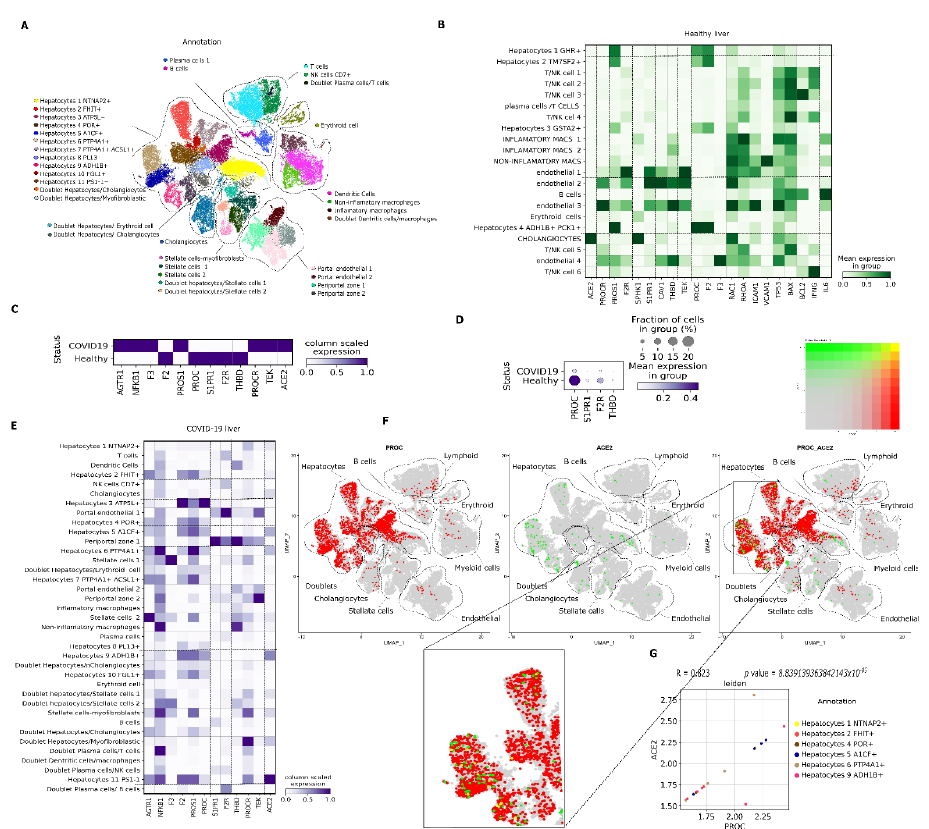
Figure 2. Expression of genes involved in activated protein C (APC) signaling in the liver from healthy individuals and patients with coronavirus disease 2019 (COVID-19) based on single-cell transcriptomics. ( A ). Uniform Manifold Approximation and Projection (UMAP) embedding of liver cells via single-cell RNA sequencing (scRNA-Seq) droplet-based single-cell platform, showing single liver parenchymal cells grouped into 36 clusters. ( B ). Matrix plot showing expression of genes related to APC signaling according to the cell type in a healthy liver. ( C ). Matrix plot showing expression of genes related to APC signaling in patients with COVID-19 versus healthy individuals. ( D ). Dot plot representation of downregulated genes in patients with COVID-19. ( E ). Matrix plot showing expression of genes related to APC signaling according to the cell type in an autopsy liver sample from a patient with COVID-19. ( F ). Visualization of co-expression (yellow) by color overlap. PROC (red) is barely co-expressed with ACE2 (green) in hepatocyte clusters. ( G ). Spearman’s correlation of subset of cells that co-expressed PROC and ACE2 . Table 1. Differentially expressed genes related to protein C (PC) activation and signaling in samples from patients with coronavirus disease 2019 (COVID-19). Differentially expressed genes between patients with COVID-19 and healthy controls were determined with Scanpy’s implementation of the two-sided Wilcoxon rank-sum test. Genes lacking a value (denoted as ‘-’) did not reach the logFC threshold of 0.1. COVID-19%: percentage of cells in the COVID-19 group that expresses the gene. Healthy%: percentage of cells in the healthy group that expresses the gene. Abbreviations—logFC: log fold change; PBMC: peripheral blood mononuclear